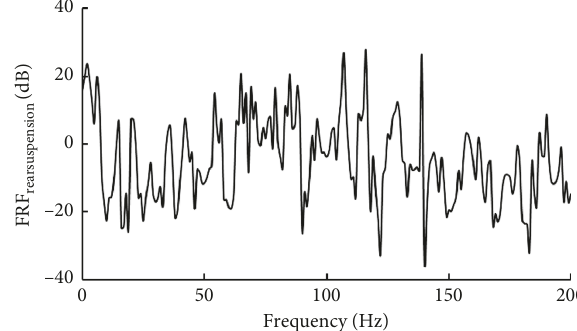
Figure 23: Engine flywheel torsional vibration angular velocity at 1500r/min engine